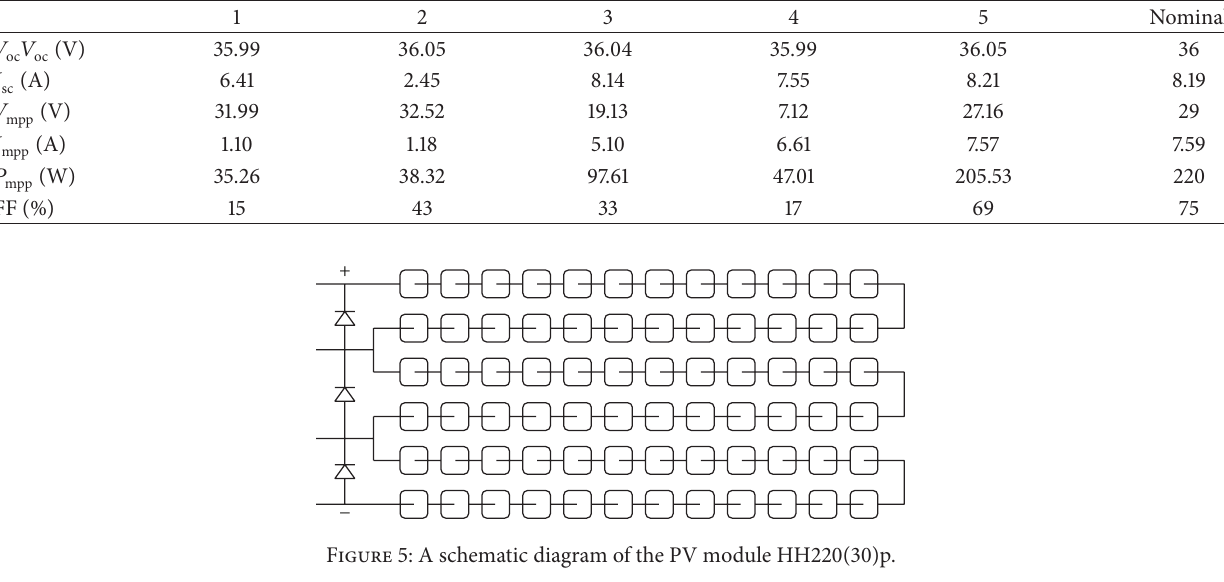
Table 4: Key parameters of the PV modules shaded by the wire pole under STC.